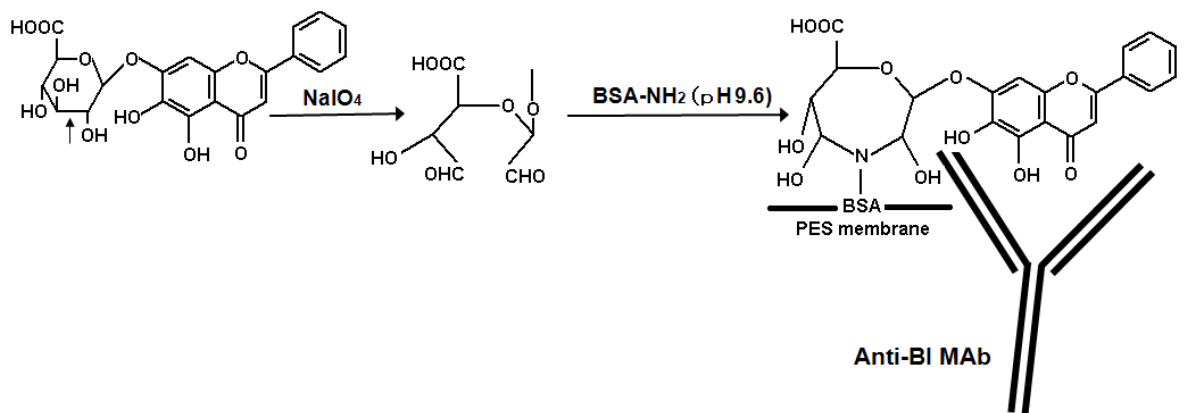
Figure 3. Schematic diagram illustrating the immunostaining of BI onto polyethersulfone (PES) membrane and the detection using an anti-BI